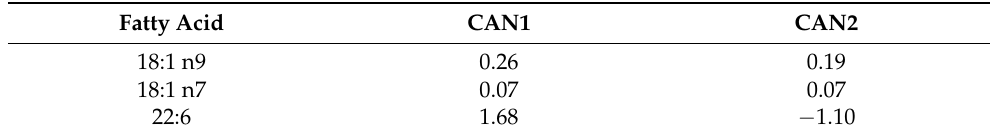
Table 8. Pooled within class standardized canonical coefficients (loadings) on the first two canonical variates estimated from the fatty acid profiles of northern Largemouth bass whole body samples (Trial